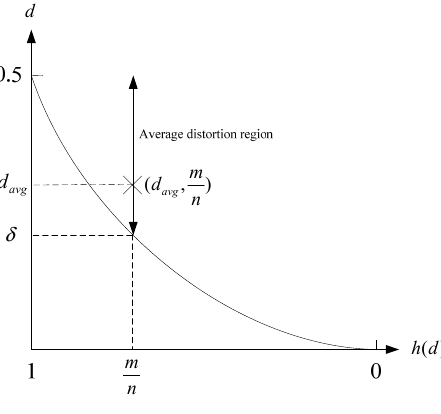
Figure 2. Rate-distortion function.